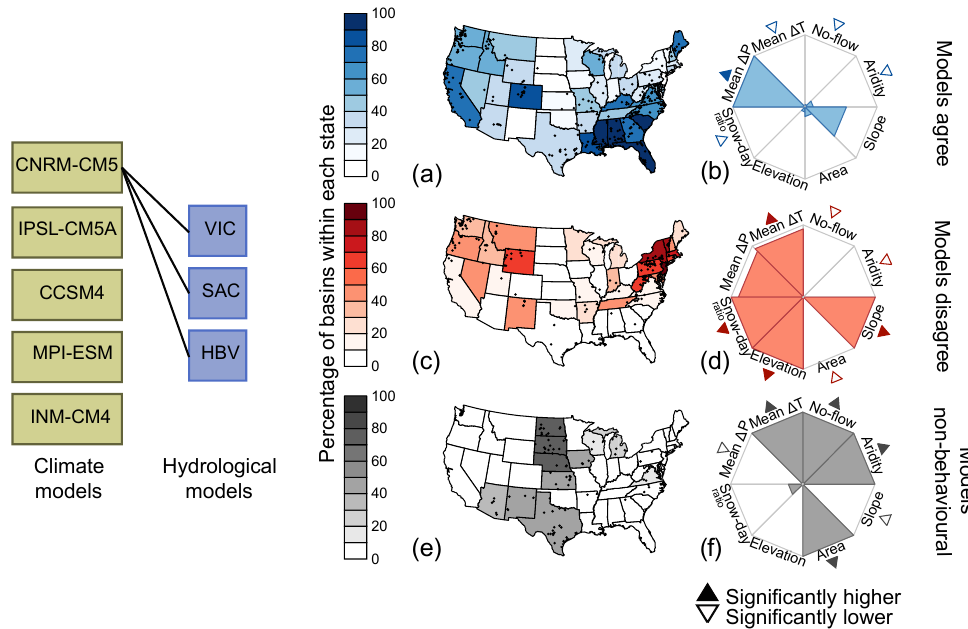
Figure 5. Spatial distribution of the basins in which the three hydrologic models agree on the sign of change in discharge timing (a) and disagree on the sign (c) , and of the basins in which all models were non-behavioural for the current climate with observed forcing (e) . The rose plots (b, d, and f) show the standardized catchment and climate characteristics for catchments shown in (a) , (c) , and (e) , respectively. In the rose plots, “mean (cid:49)P ” stands for the mean change in precipitation, and “mean (cid:49)T ” for the mean change in temperature. The hydrologic models (VIC: Variable Infiltration Capacity model; SAC: Sacramento Soil Moisture Accounting model; HBV: Hydrologiska Byråns Vatten- balansavdelning model) were forced with CNRM-CM5 projections (Representative Concentration Pathway 8.5). The characteristics in the rose plots have been standardized from 0 to 1, where 0 represents the lowest value of the characteristics for the three displayed groups, and 1 the highest value of the characteristics for the three displayed